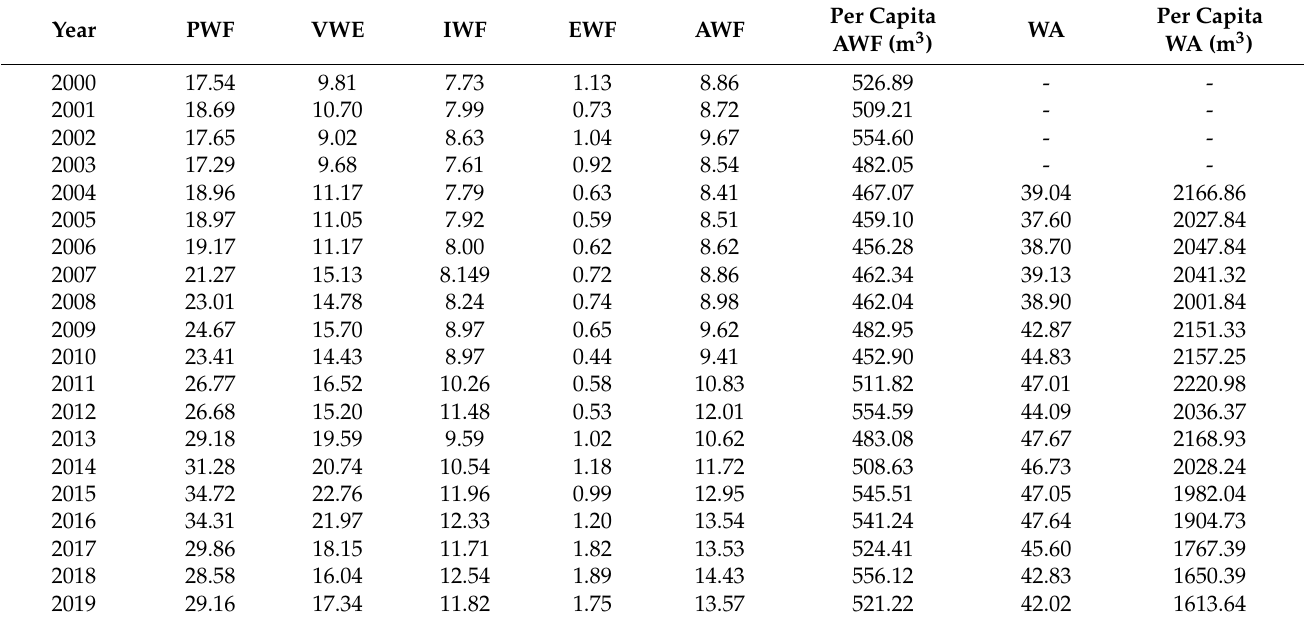
Table 4. Statistical table of various types of water footprints (10 8 m 3 ) in Hotan from